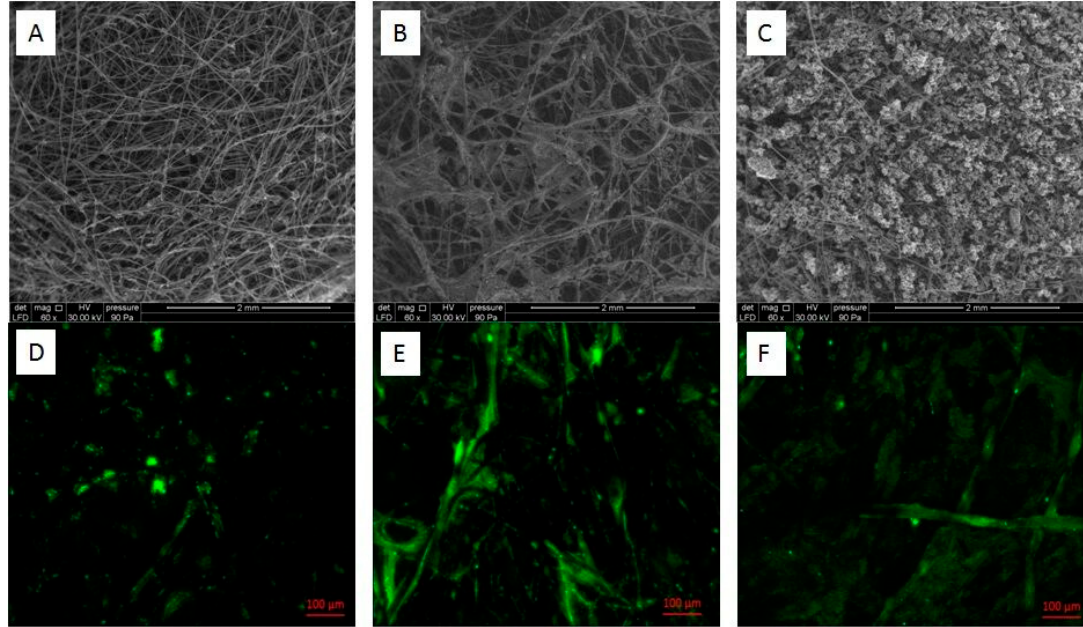
Figure 5. ESEM and epifluorescence microscopy images of bioanodes formed on unmodified carbon felt electrodes ( A and D ), LTA zeolite-modified electrode ( B and E ) and bentonite-modified electrode ( C and F ) polarized at − 0.2V/ECS for 45 days in tannery wastewater supplemented with 20 mM of acetate and inoculated with acclimated activated sludge.